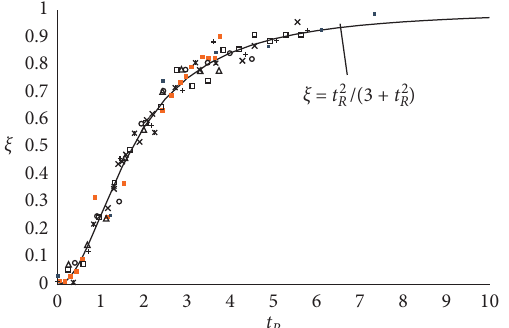
Figure 1: Growth trends of many microbial cultures in different environmental conditions gathered in a single plot of reduced variables. Reported from